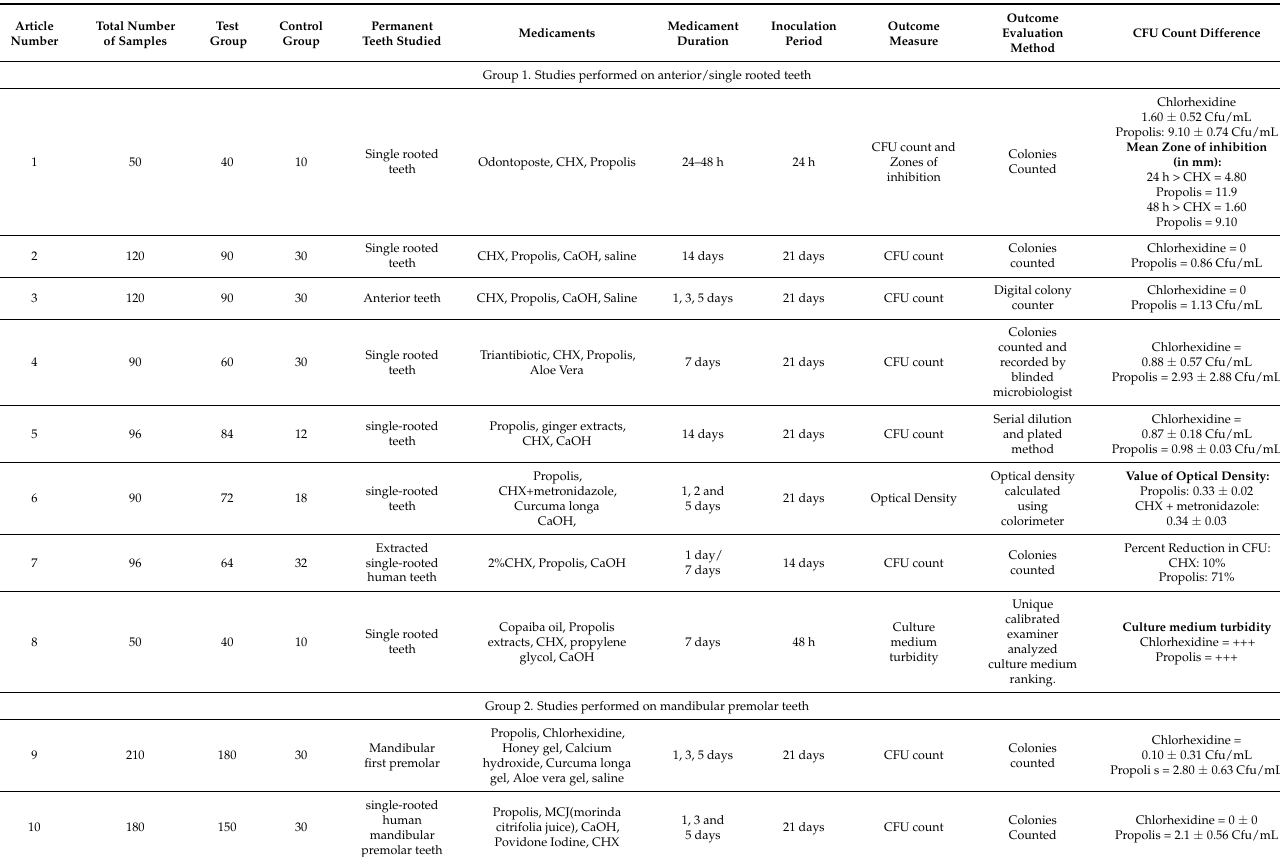
Table 2. Outcomes of studies included in systematic